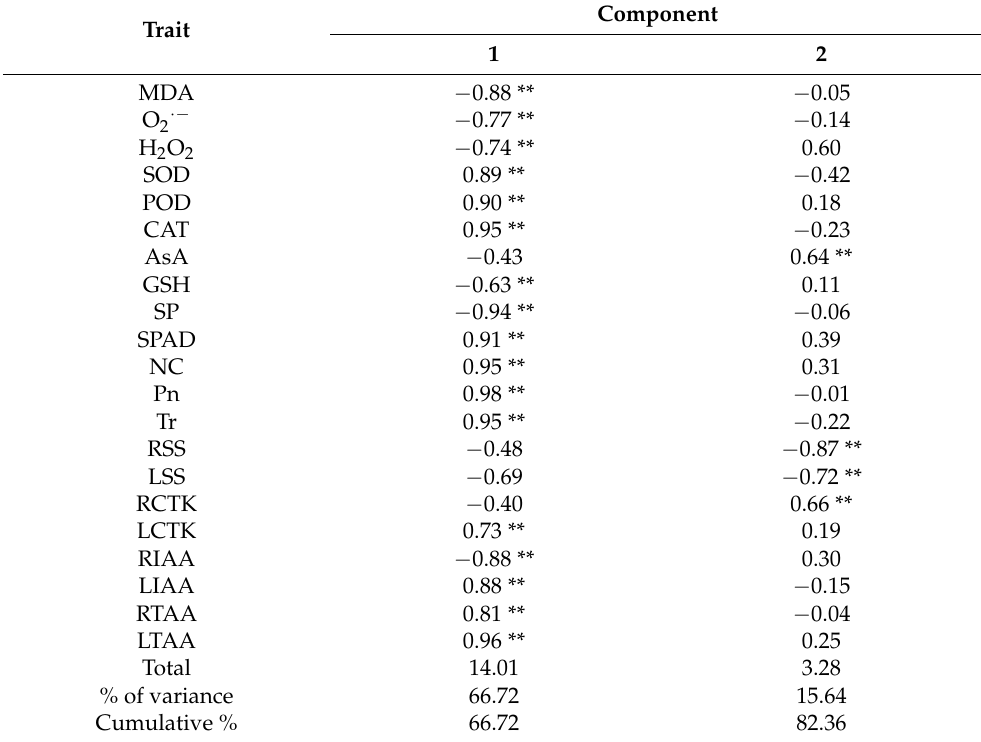
Table 4. Eigenvalues of each principal component.